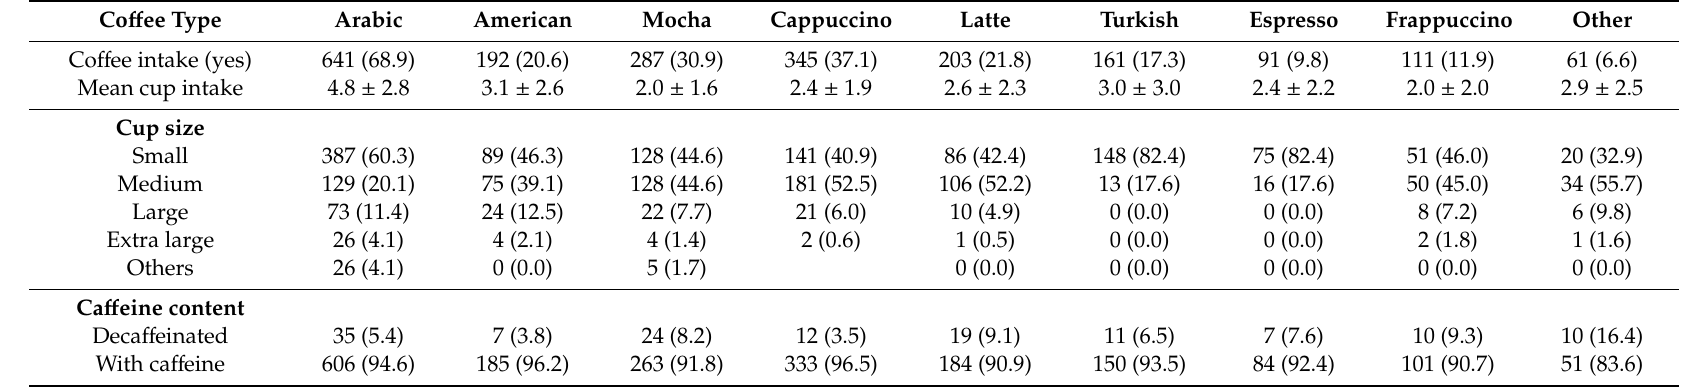
Table 3. Frequency of co ff ee consumption by